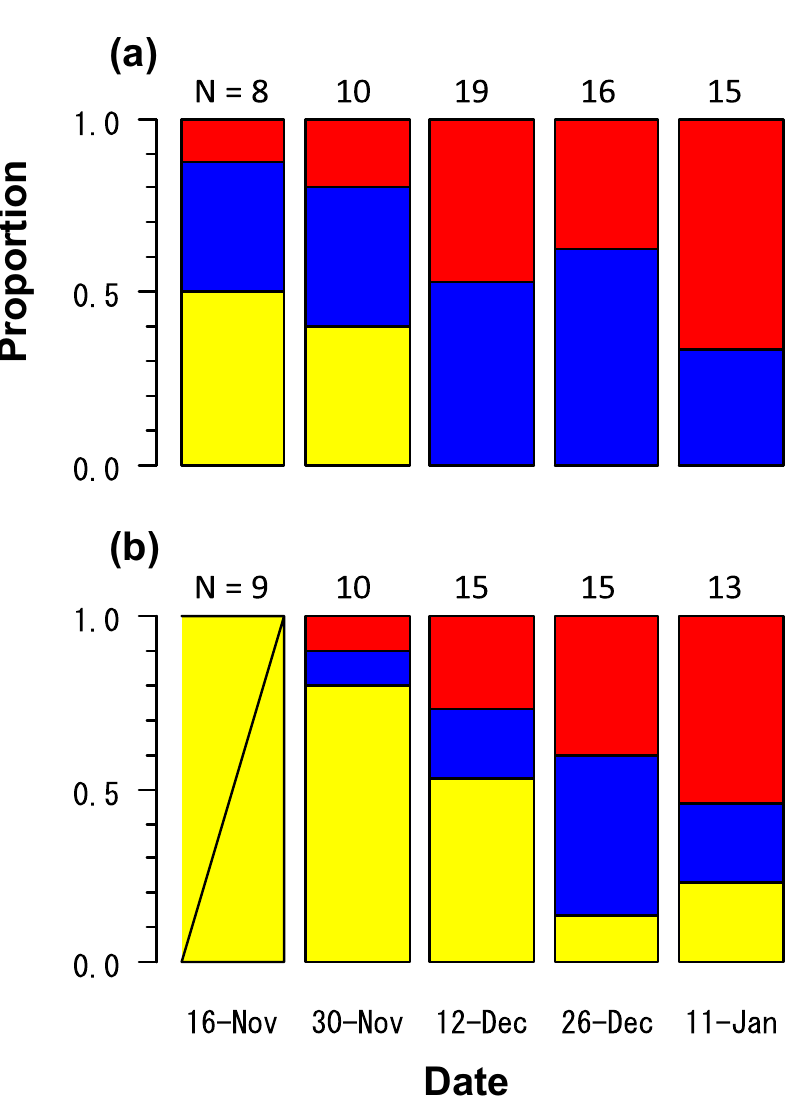
Fig 2. Temporal changes in the proportion of mature and immature western sand lance ( Ammodytes japonicus ) in the (a) high ration and (b) low ration treatments in Experiment II. Yellow, blue, and red bars indicate immature individuals, mature males, and mature females, respectively. Numerals indicate sample